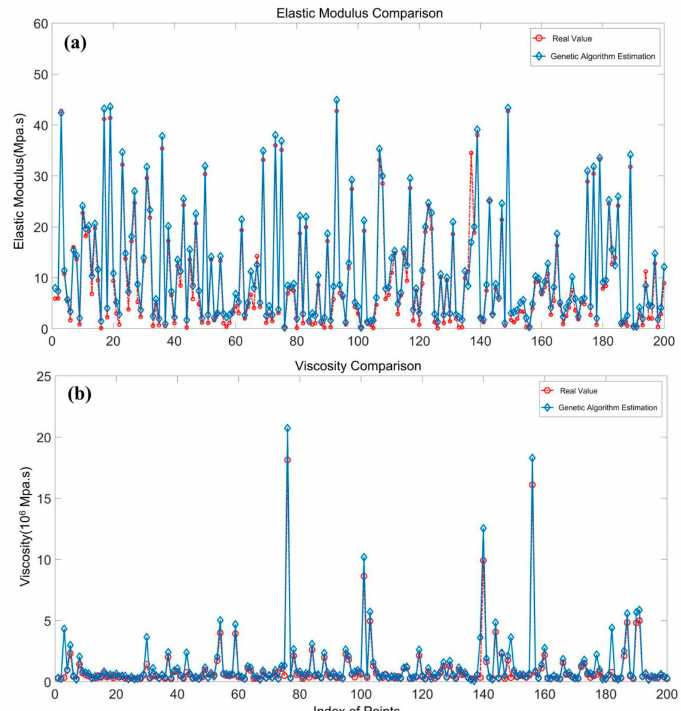
Figure 2. Estimated rheological parameters compared with real values in the simulation (the noise level is 0.5